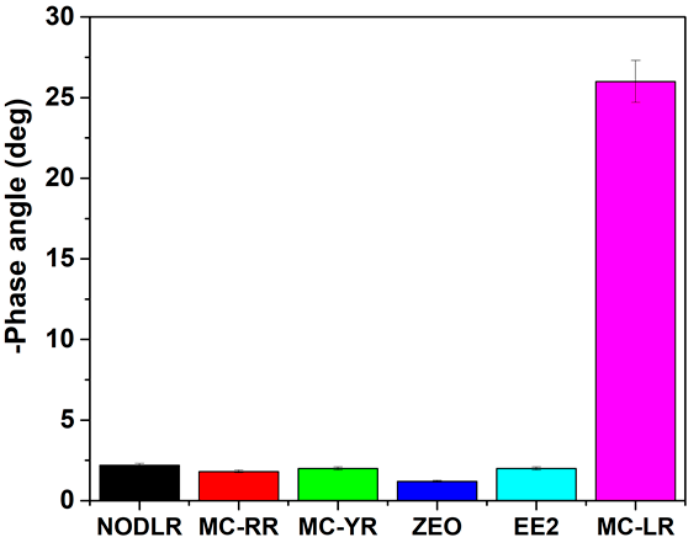
Figure 12. Bar chart of aptasensor (GCE PDMA–PVS–Ag 0 SH-Apt) responses to toxins.